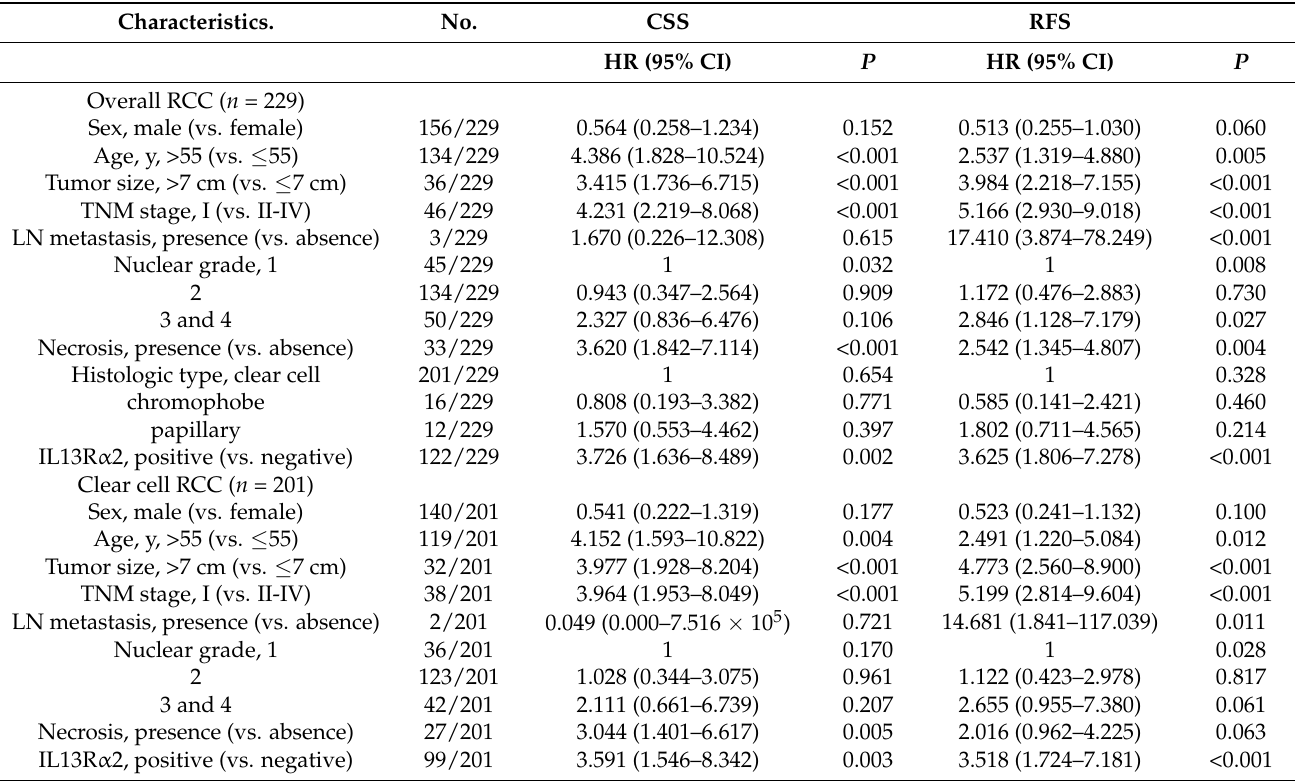
Table 2. Univariate Cox regression analysis of cancer-specific survival and relapse-free survival in renal cell carcinoma patients.